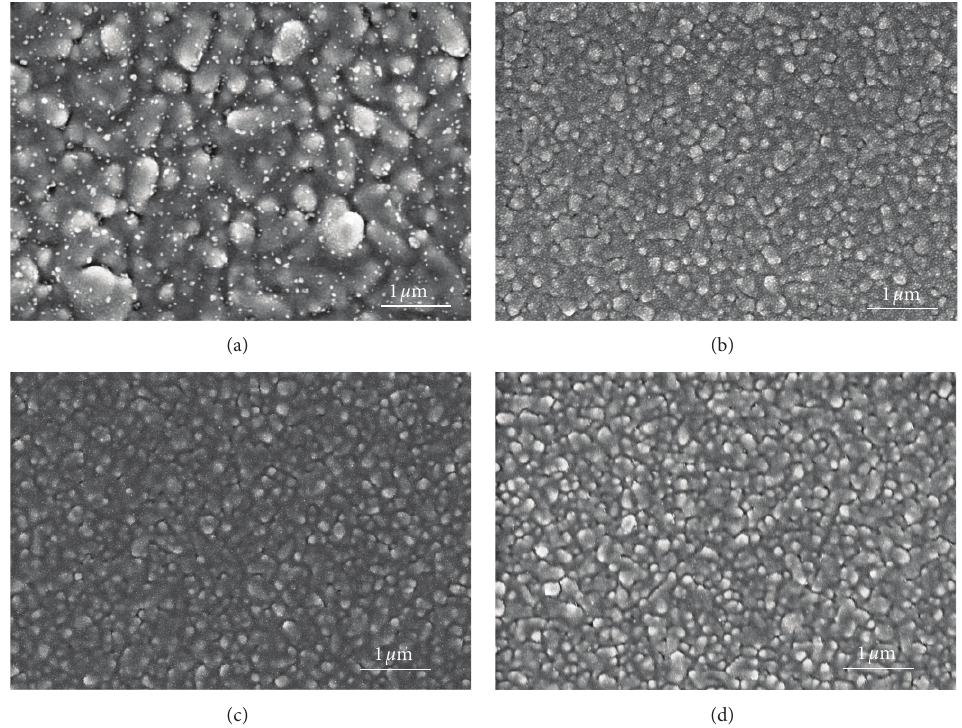
Figure 3: FESEM images of CIS samples prepared at temperature (a) room temperature, (b) 250 ∘ C, (c) 300 ∘ C, and (d) 350 ∘ C.